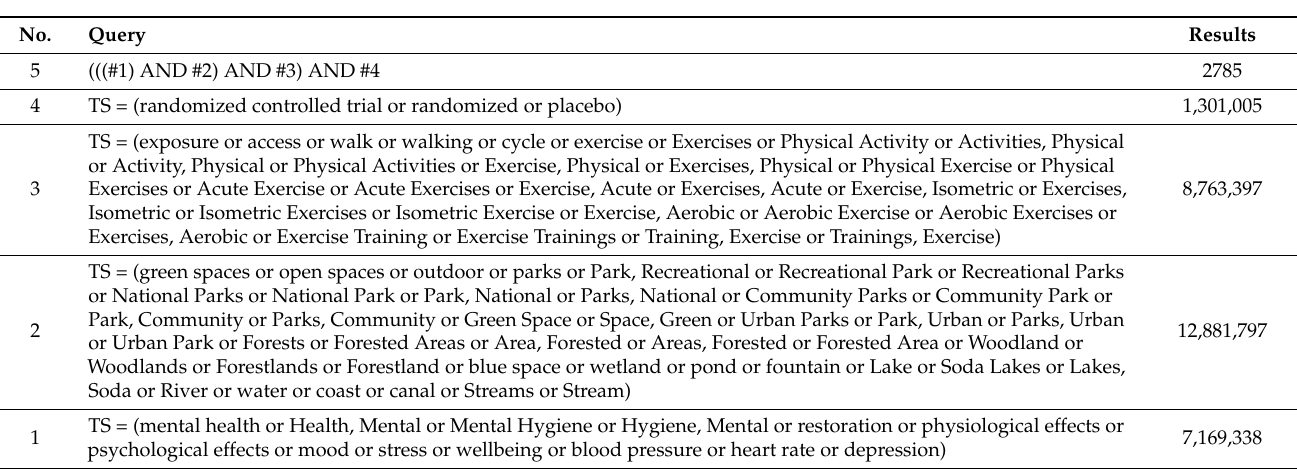
Table A2. Search content used for systematic search on evidence for the restorative benefits of exposure to green spaces on Web of Science database (updated on 6 December